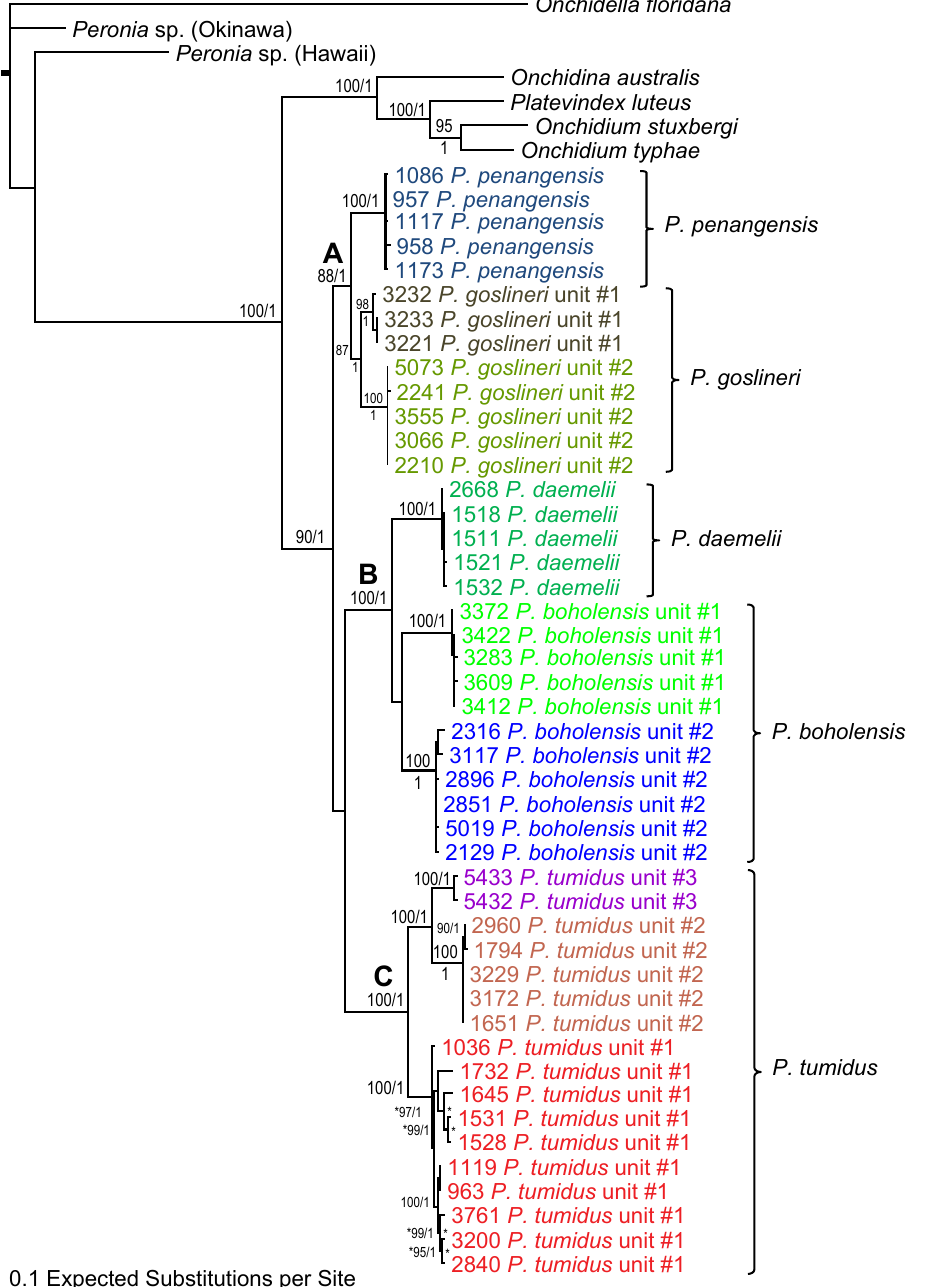
Fig. 1. Phylogenetic relationships within Paromoionchis gen. nov. based on concatenated COI, 16S and 12S sequences for 53 individuals (including 7 outgroups). Numbers by the branches are the bootstrap values (maximum likelihood analysis, ML) and the posterior probabilities (Bayesian analysis). Only numbers > 70% (ML) and > 0.9 (Bayesian) are indicated. Numbers for each individual correspond to unique identifiers for DNA extraction. All sequences for specimens of Paromoionchis gen. nov. are new. Some outgroup sequences are from previous studies (Dayrat et al. 2011a, 2016; Dayrat & Goulding 2017). Information on specimens can be found in the lists of material examined and in Table 1. The letters A, B and C correspond to three clades which are referred to in the text. The color used for each (mitochondrial) unit is the same as that used in Figs